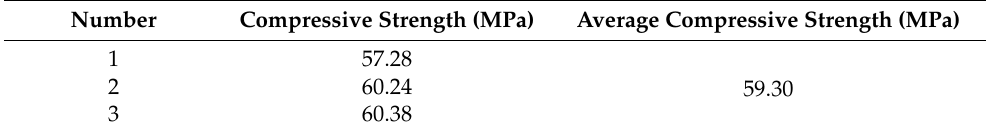
Table 3. Mechanical properties of